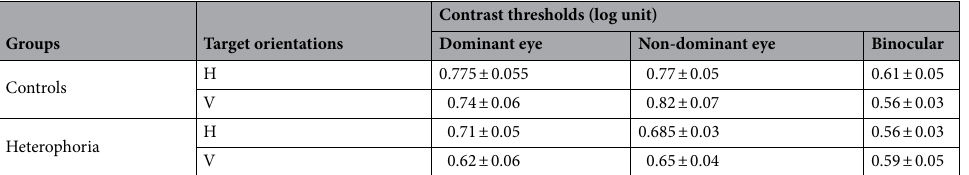
Table 4. Values of contrast detection threshold (in log units) obtained for each group for the different target orientations during different types of eye viewing (Experiment 2). H stands for horizontal and V for vertical